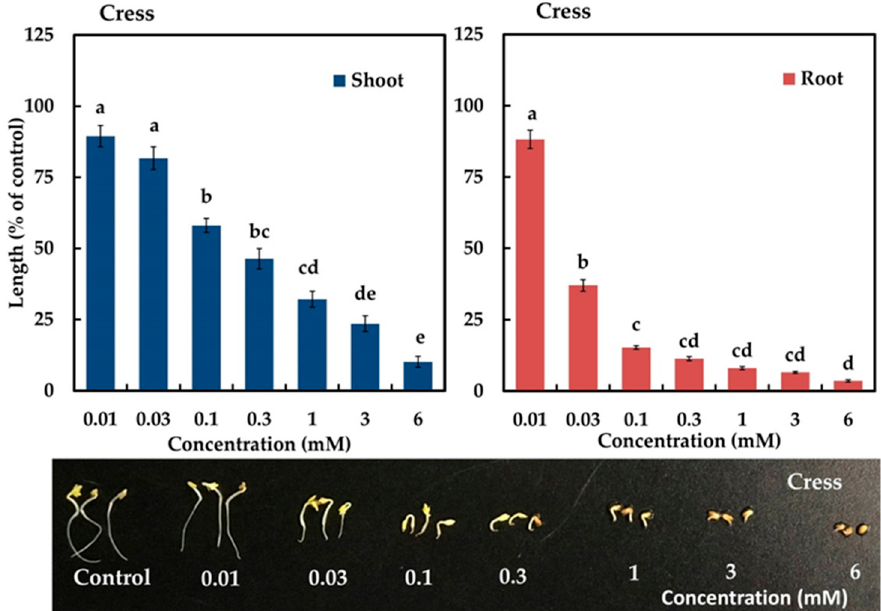
Figure 5. Inhibitory activity of the active compound on the shoot and root growth of cress. The bars on each experiment express mean ± SE from three replicates, each with 10 seedlings ( n = 30). Di ff er- ent le tt ers indicate signi fi cant di ff erences among the treatments (Tukey’s HSD, p < 0.05).